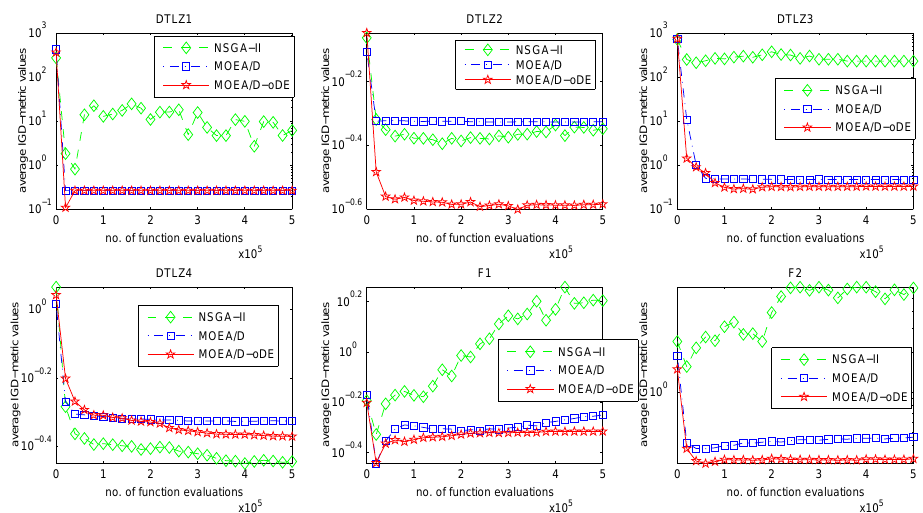
Figure 5. Evolution of the mean of IGD metric values for six-objective test problems.